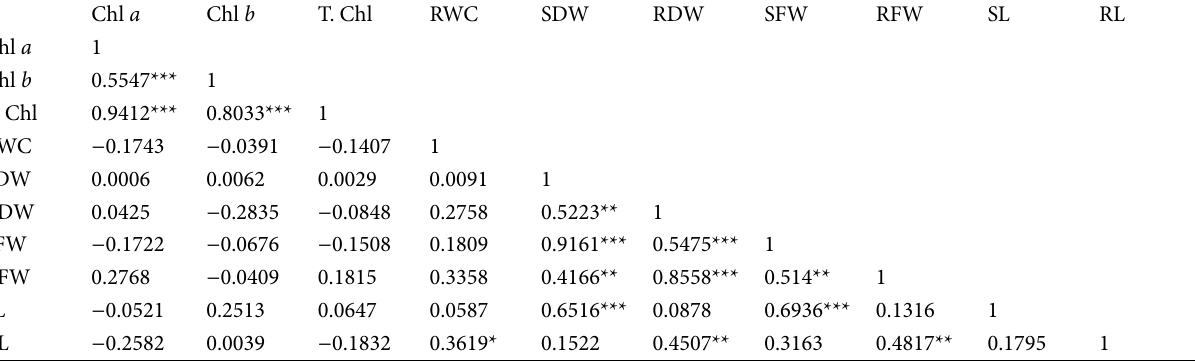
Table 4 Pearson correlation matrix showing the correlations between growth parameters of cultivars under 0.8 mg/L arsenic stress.